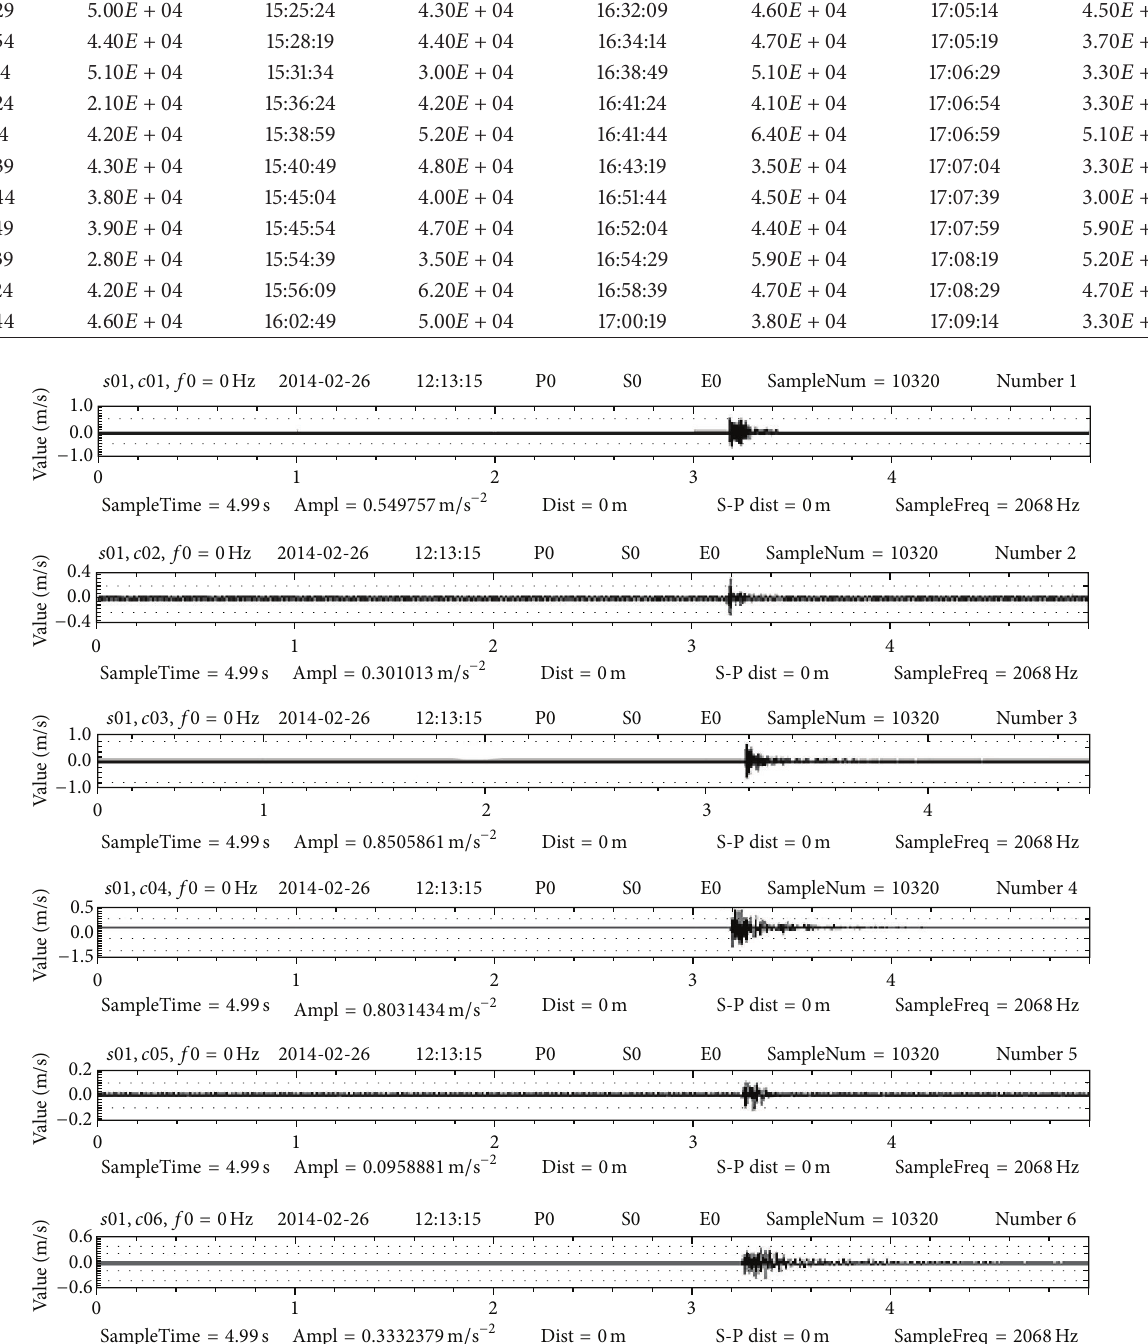
Figure 7: Example waveforms of a microseismic event recorded in artificial blasting